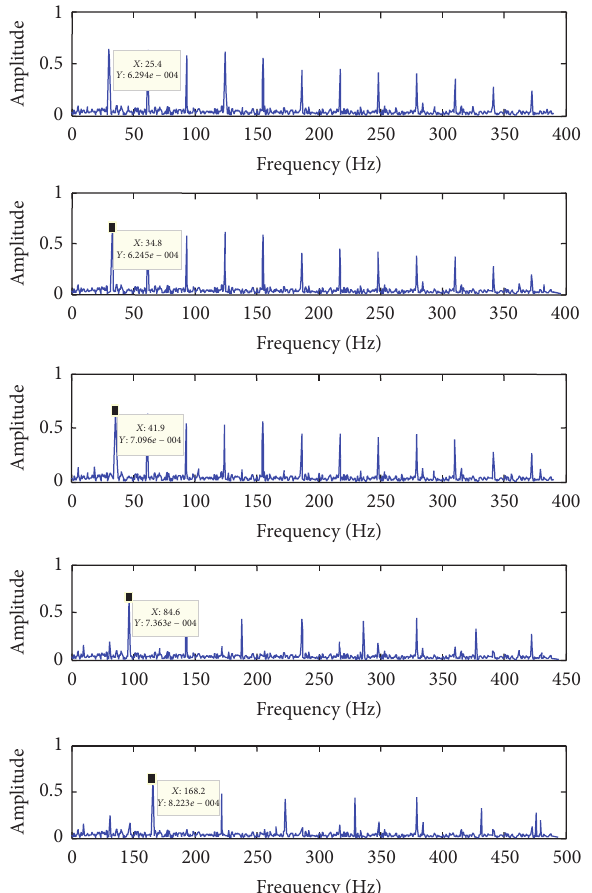
Figure 9: FFT analysis of RD after frequency correction at 1500 RPM, 2000 RPM, 2500 RPM, 5000 RPM, and 10000RPM,